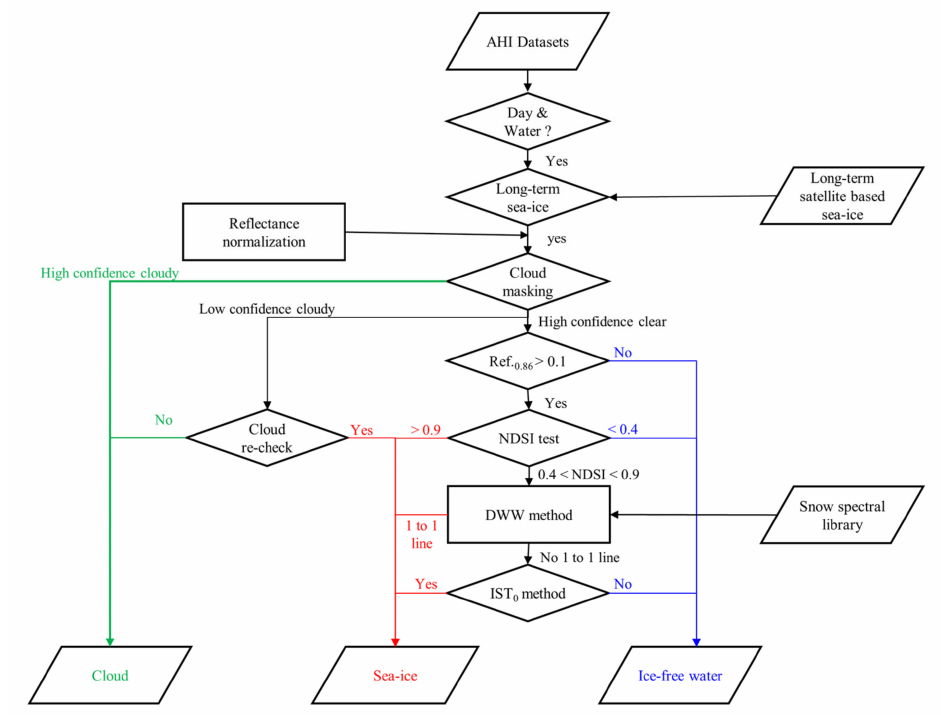
Figure 2. Flow chart showing GK-2A / AMI sea-ice detection algorithm; green line (cloud), red line (sea ice) and blue line (ice-free water).